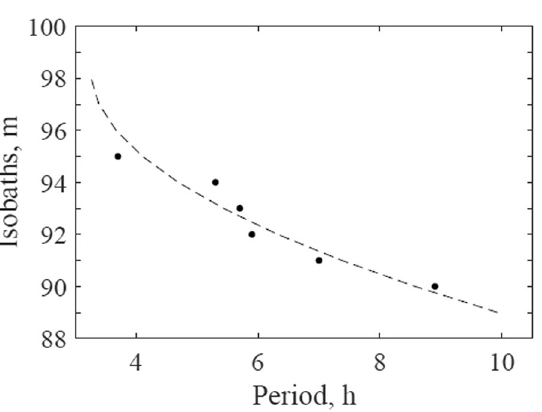
Figure 9. Points refer to the first mode seiche periods obtained from modelling using the different storage isobaths for the lake, and the solid line is the fitting curve obtained by Eq.